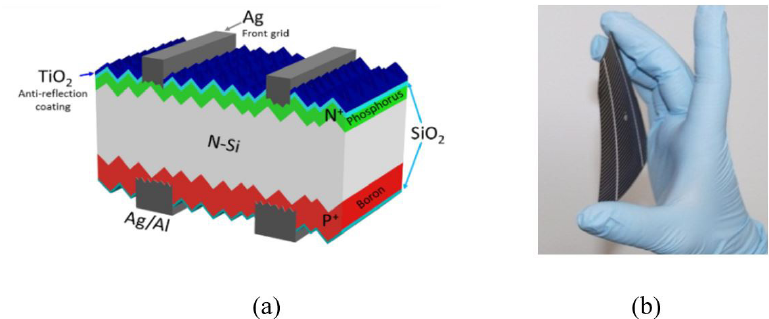
Figure 2. (a) Scheme of the solar cell with rear emitter and (b) thin device processed.